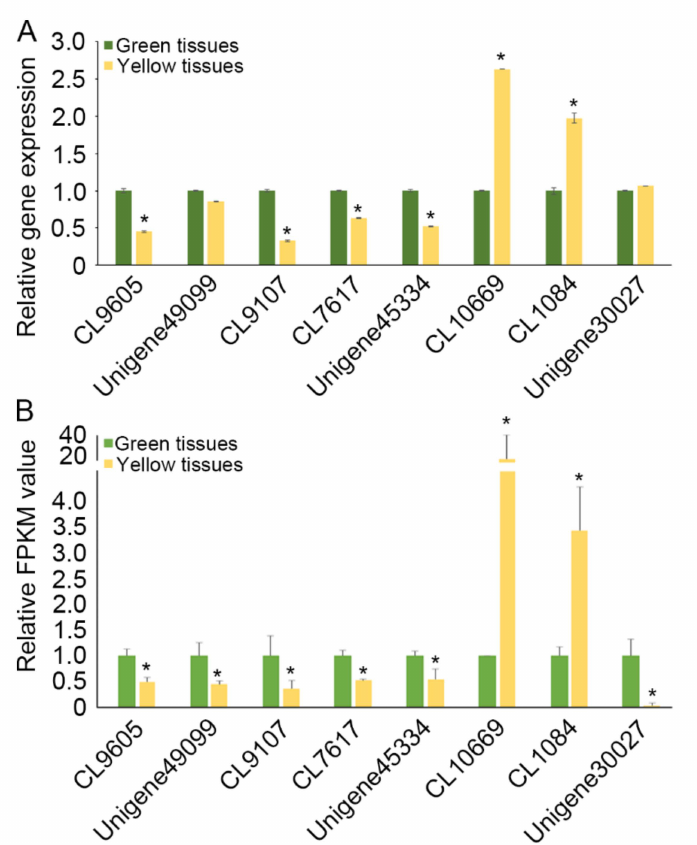
Figure 6. Validation of unigenes that respond to chlorophyll deficiency. ( A ) Relative unigene expression values detected by qPCR. Relative transcript levels were normalized with CmEF1 α as the standard. The green and yellow tissues from three leaves in a single plant were bulked for qRT-PCR test. Error bars indicate the standard error of the mean of three technical replicates. ( B ) Relative unigene expression values detected by RNA-seq. Error bars indicate the standard error of the mean of three biological replicates. * p < 0.05 when compared to the control by one-tailed unpaired t -test. Error bars represent